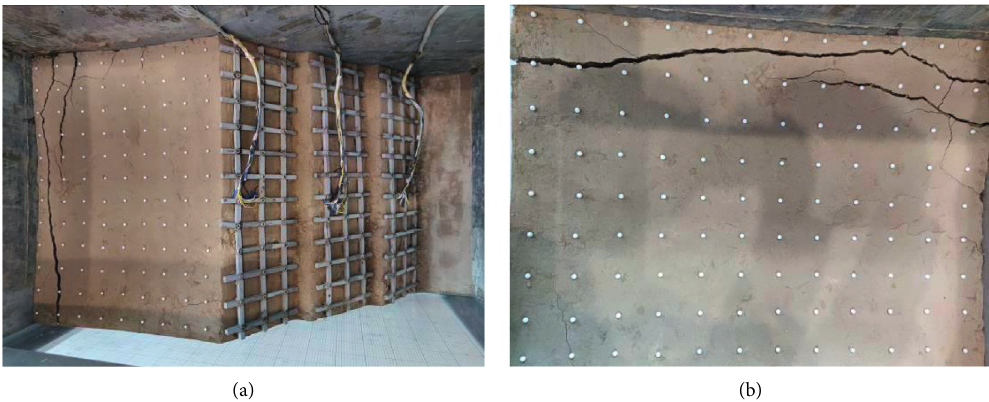
Figure 9: Slope deformation after test. (a) Overall deformation diagram of slope. (b) Partial diagram of slope top